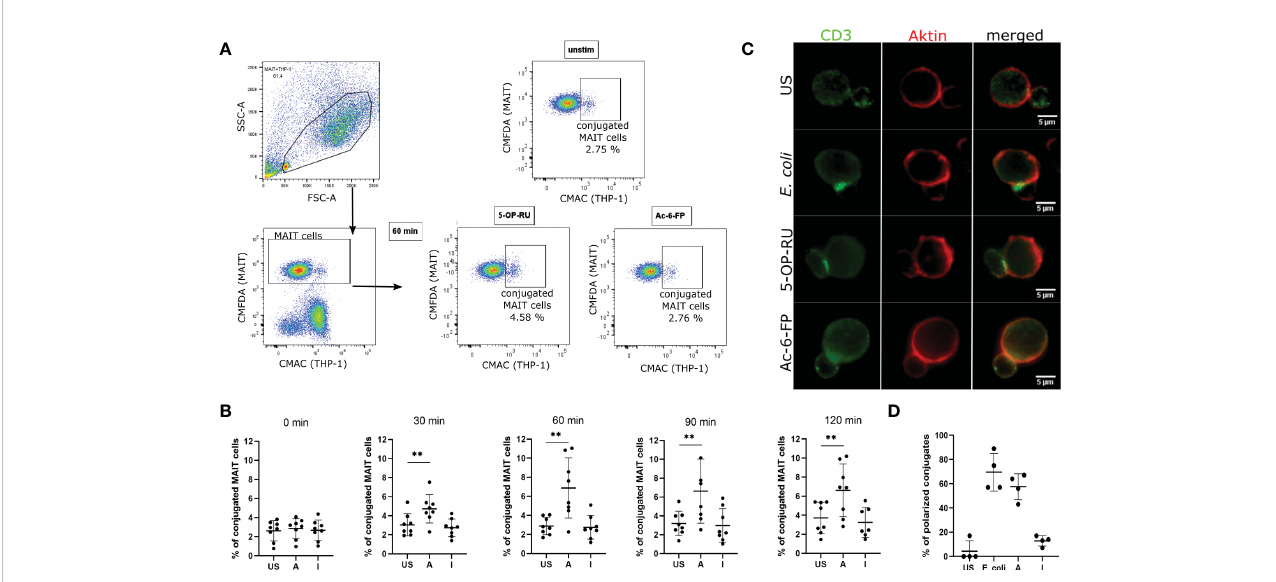
FIGURE 2 Conjugation frequency between MAIT and THP-1 cells in presence of different MR1 ligands. (A) THP-1 cells were loaded with 50 ng/ml 5-OP-RU or Ac- 6-FP for 5 hours at 37 °C. FACS-sorted MAIT cells were stained with CMFDA cell tracker dye whereas metabolite-stimulated THP-1 cells were stained with CMAC cell tracker dye. Subsequently, MAIT and THP-1 cells were paired (1:1 ratio) and conjugate formation was analyzed after indicated time points by fl ow cytometry. MAIT-THP-1-conjugates were identi fi ed as CMFDA + CMAC + cells. The frequency of conjugated MAIT cells was determined. (B) Frequency of conjugated MAIT cells with THP-1 cells is shown after different periods of pairing. Data from four independent experiments from eight donors are shown. Asterisks indicate signi fi cant differences determined by Wilcoxon matched-pairs signed rank test; p** < 0.01. Horizontal lines indicate mean ± SD. (C) MR1-loaded THP-1 cells were paired with FACS-sorted MAIT cells for 30 minutes on poly-L-lysine coated coverslips at 37 °C. Cells were stained for CD3 (green) and actin (red). Representative images of conjugates are shown after focusing stacked images by extended depth of fi eld (edf). (D) Quanti fi cation of CD3 polarization towards MTOC in MAIT cells conjugated to THP-1 cells (n=4 donors; at least 32 conjugates were analyzed per condition). US = unstimulated; A = 5-OP-RU; I =